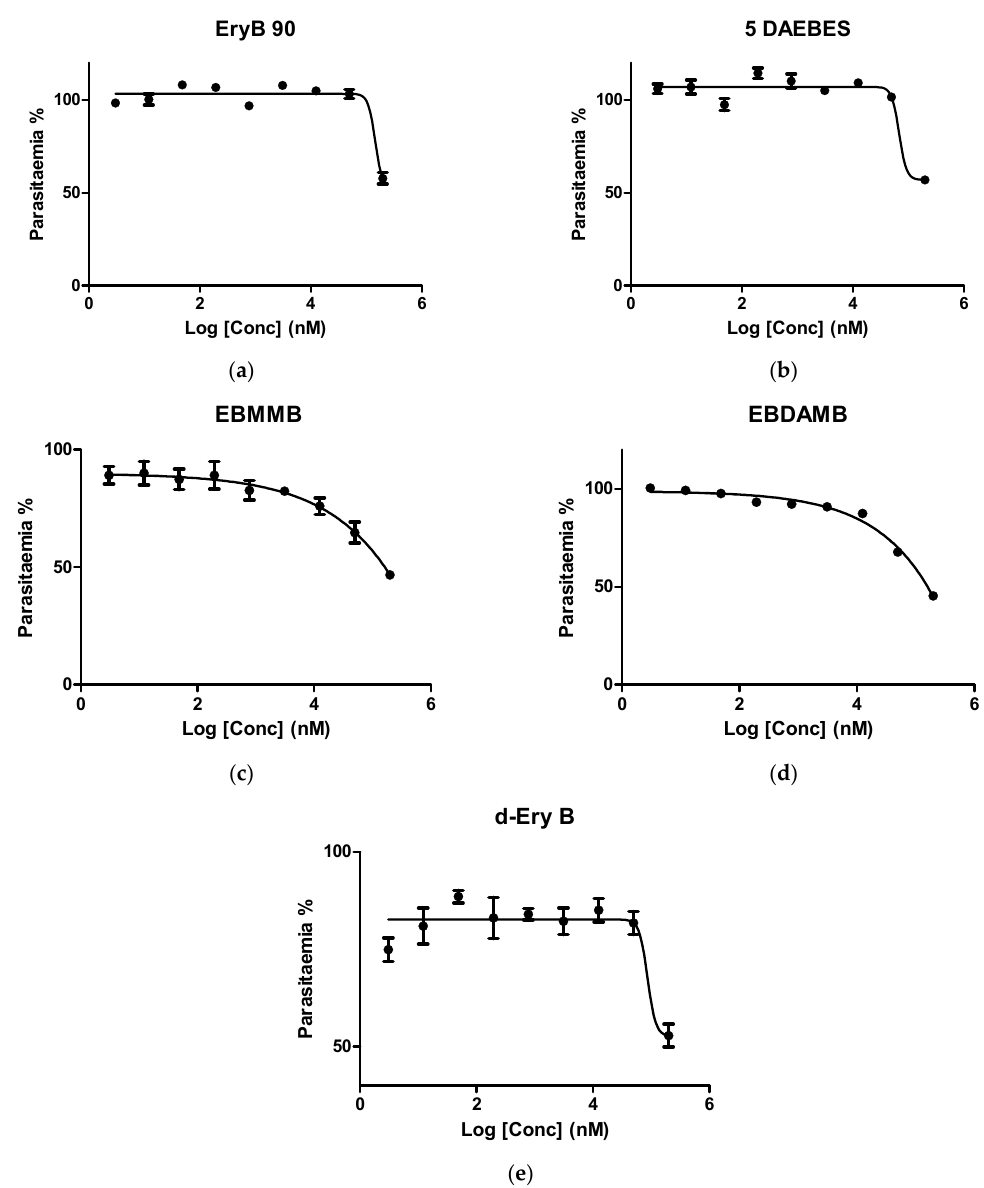
Figure 2. Dose-response curves for ( a ) erythromycin B 9-oxime (EryB 90), ( b ) 5-desosaminyl erythronolide B ethyl succinate (5DAEBES), ( c ) erythromycin B 2 ′ -[3-(morpholinomethyl) benzoate] (EBMMB), ( d ) erythromycin B 2 ′ -[3-(dimethylaminomethyl)benzoate] (EBDAMB), and ( e ) 8- d -erythromycin B (d-Ery B).